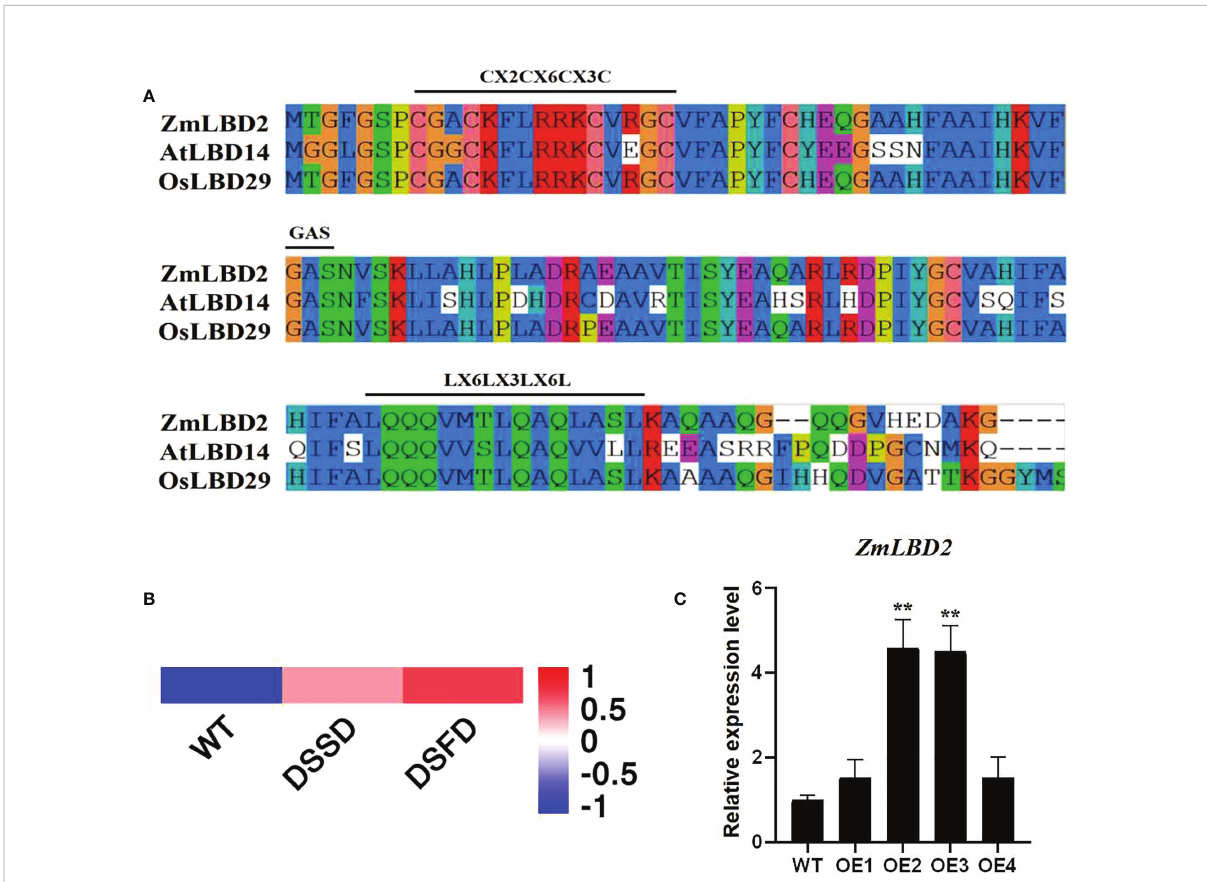
FIGURE 1 Sequence and expression pattern analysis of ZmLBD2. (A) LOB domain sequence alignment of ZmLBD2 and LBD members from Arabidopsis and Oryza sativa . The class-I LBD members had typical CX2CX6CX3C, GAS, and LX6LX3LX6L domains. The alignment was performed using DNAMAN software. (B, C) The expression of ZmLBD2 upon drought treatment in maize. Total RNA was isolated from 3-leaf seedlings grown without (0 h) or with 8% PEG6000 treatment. Transcript levels of ZmLBD2 were determined by qPCR, using Zm18S as reference genes. The ** represents p < 0.01.